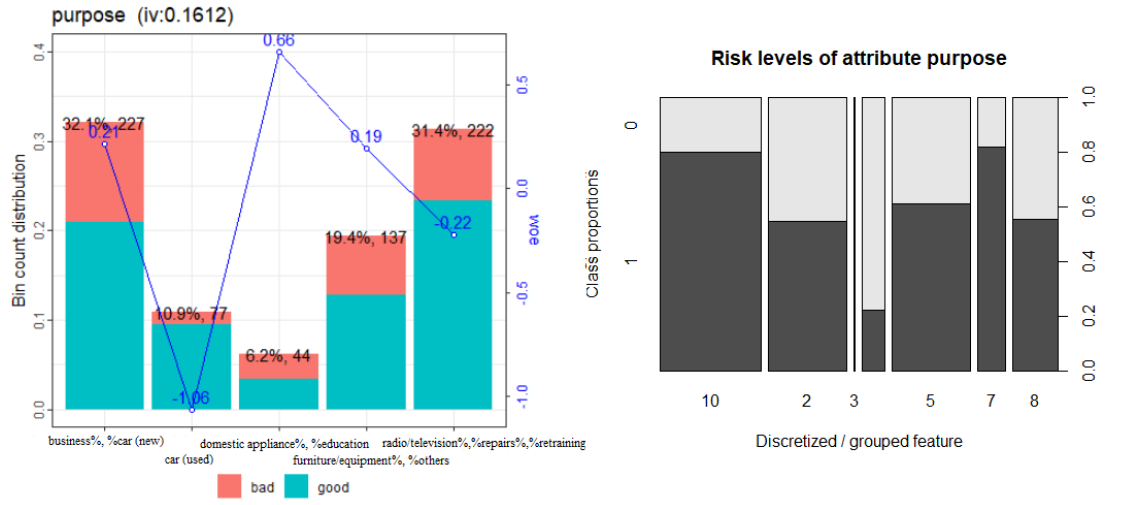
Figure 2. Visualization of the bins for the variable purpose as created by the package scorecard (left) and mosaicplot of the binning result by the package glmdisc (right).